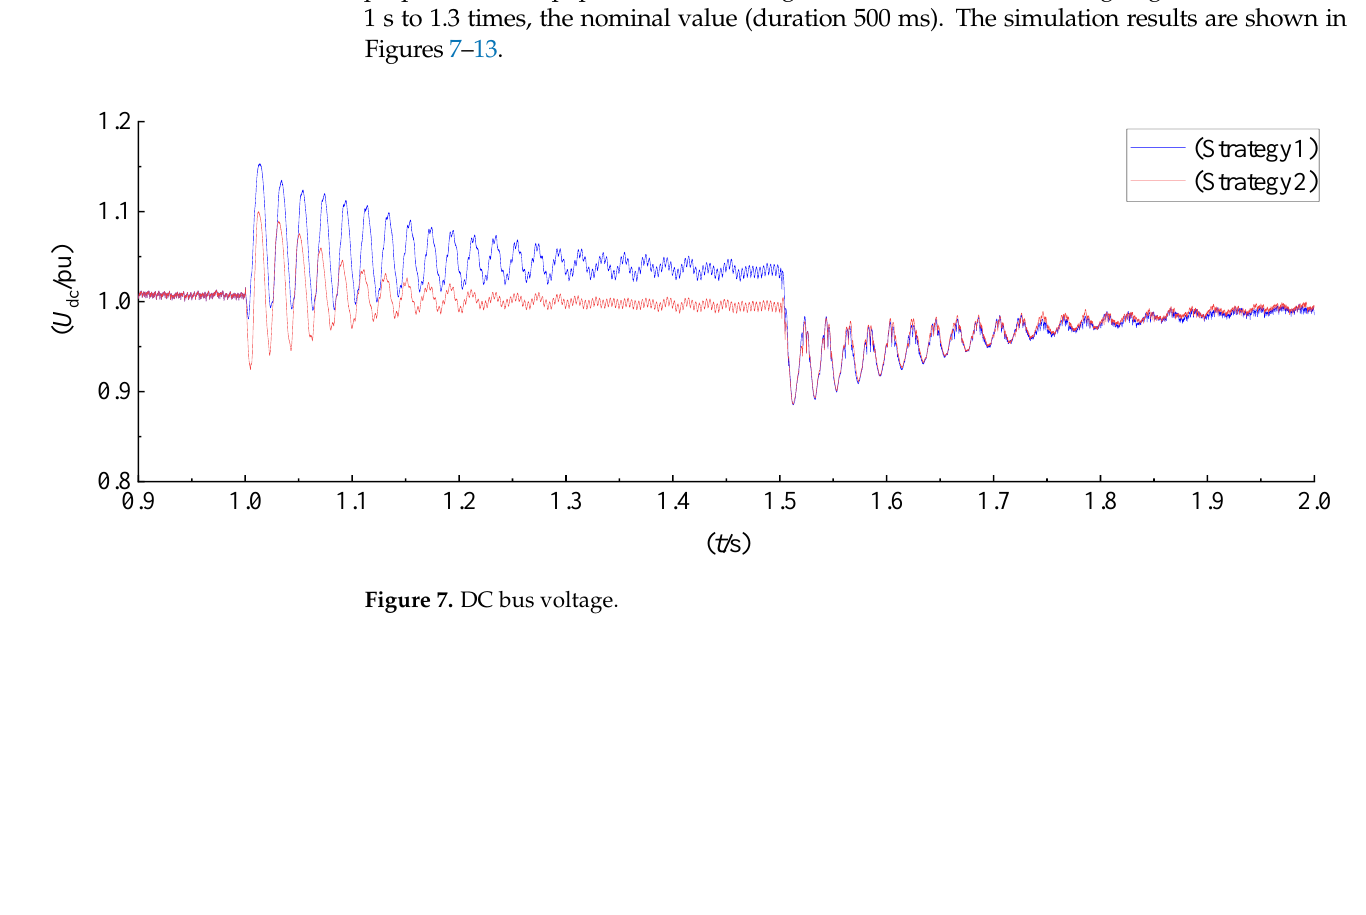
Figure 8. Active power of GSC.